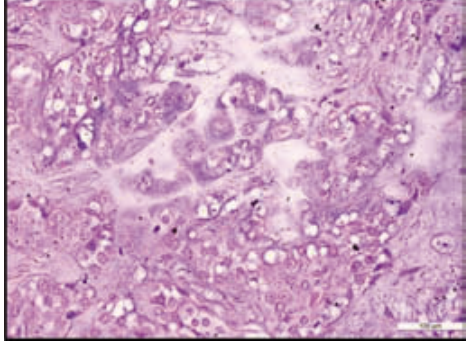
Fig.14. Tubulopapillary carcinoma – low infiltration of Tumour Associated Macrophages